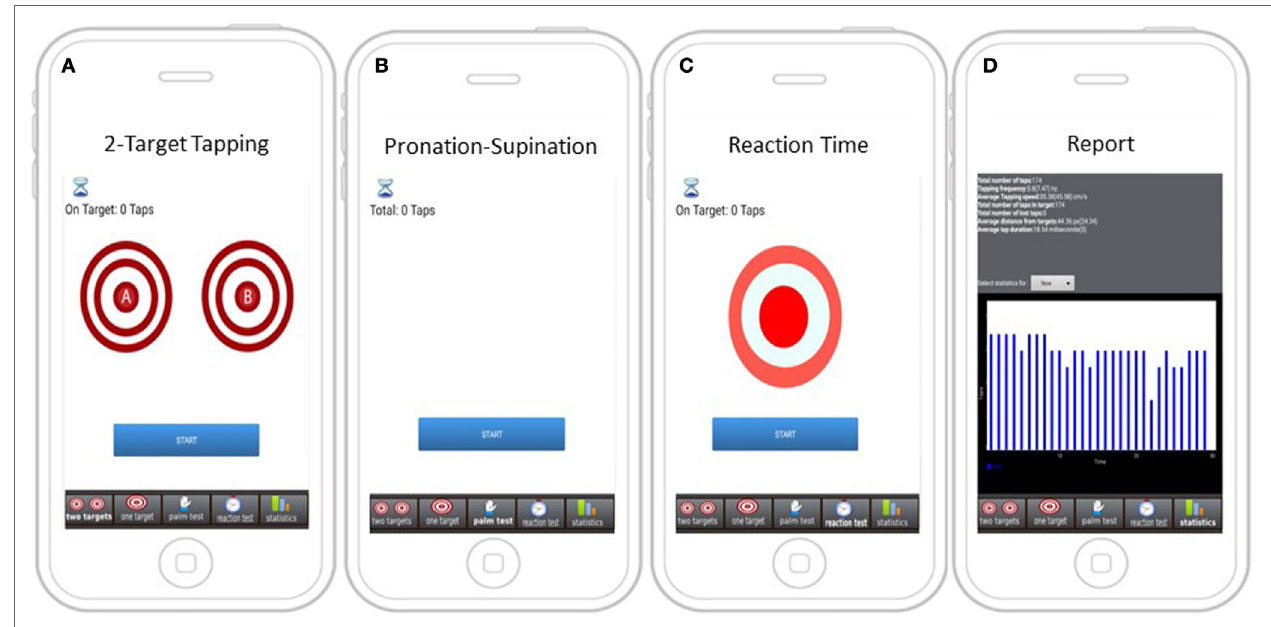
FigUre 1 | Screens with instructions for iMotor-based tasks. (A) Two-target test: participants tap alternatively with their index finger on the center of two concentric circles on the tablet screen. (B) Pronation–supination test: participants tap alternatively their palmar and dorsal surface of their hand on the tablet screen. (c) Reaction test: participants tap on target responding to a visual queue (color shift). (D) A sample report summarizing test